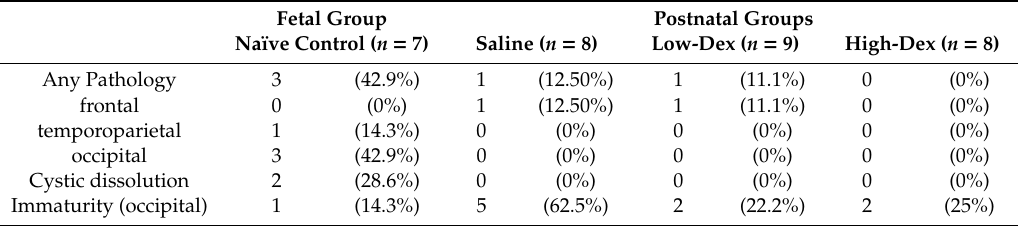
Table 4. Prevalence of pathological lesions on MRI confirmed using T1- and T2-weighted